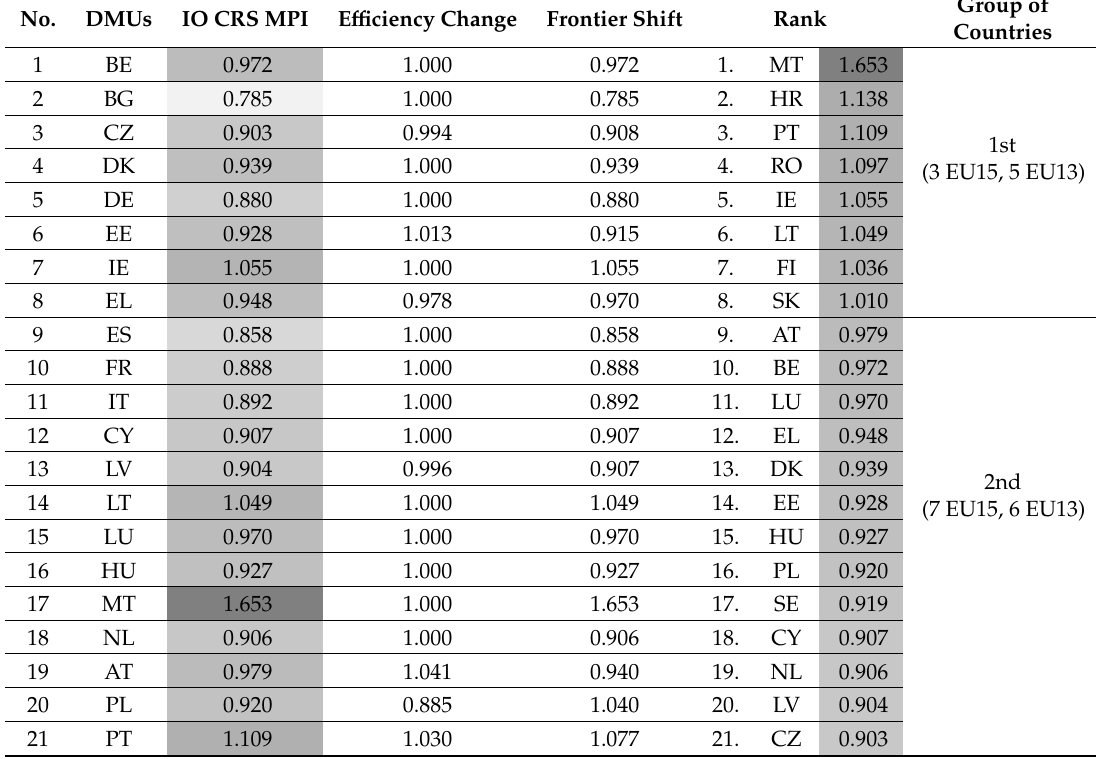
Table 8. MPI results for period 2000–2007 (source: own calculation and